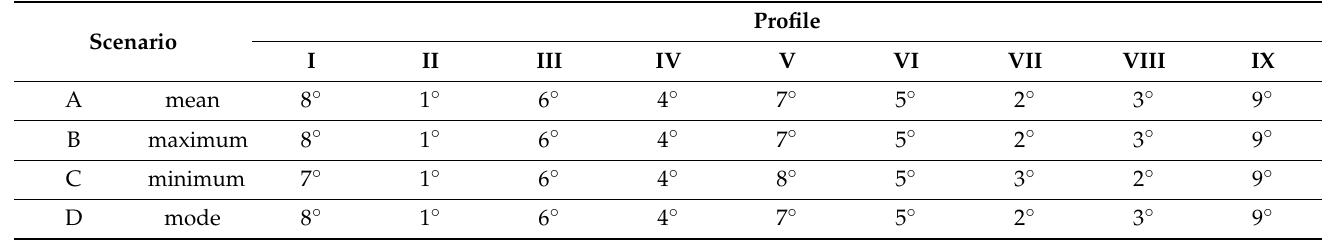
Table 5. Hierarchy of potential users obtained through application of the CP multi-criteria method.